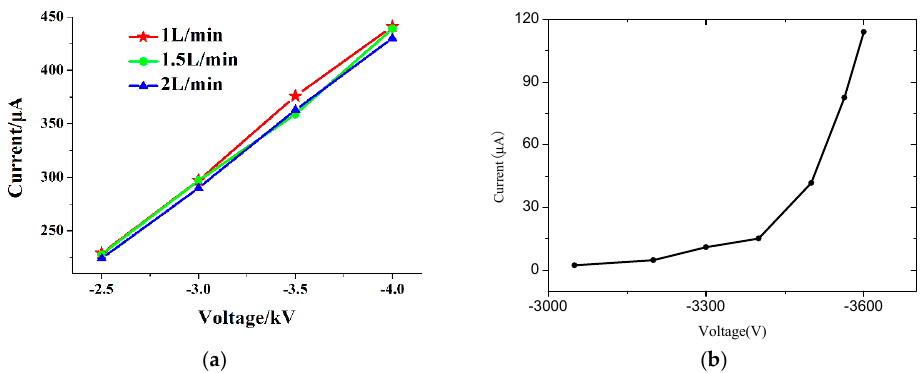
Figure 6. Discharge current with and without gas flow. ( a ) with different gas flow velocities; ( b ) without gas flow (see [23]).